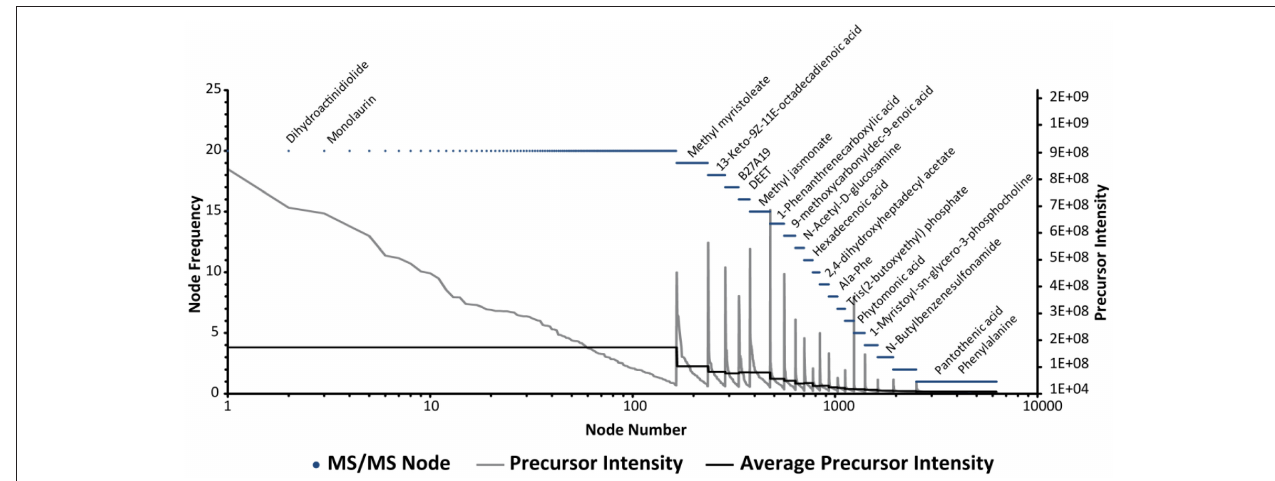
FIGURE 5 | Network Node Frequency Plot. Frequency of MS/MS features in all 20 samples. Frequency is hereby defined as the number of samples contributing to one consensus spectrum. Each dot represents one network node. Library annotations of selected nodes are shown above. The order of nodes was sorted first by frequency and in a second level by precursor intensity which is drawn on the second y-axis. The average intensity of frequency bins is shown as a solid black line.